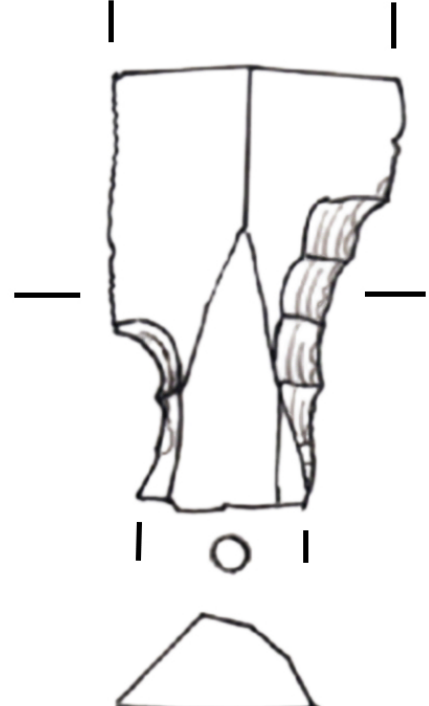
Figure 4. Tanged point fragment from Nethermills Farm (CAT 81/596: length 17